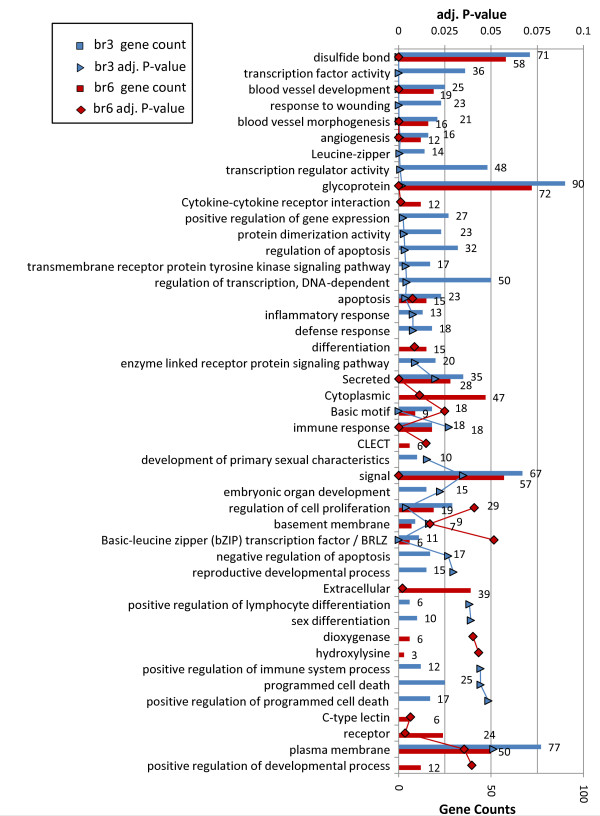
Functional groups significantly enriched among genes upregulated in Spalax brain under acute hypoxia (br3, br6). Series names: brain upregulation in hypoxia for 3% 6 hrs, and 6% 6 hrs, are denoted br3 (blue), br6 (red), respectively. Line chart (triangles, diamonds) represents Benjamini adjusted P-value of term enrichment. Bars denote gene counts.